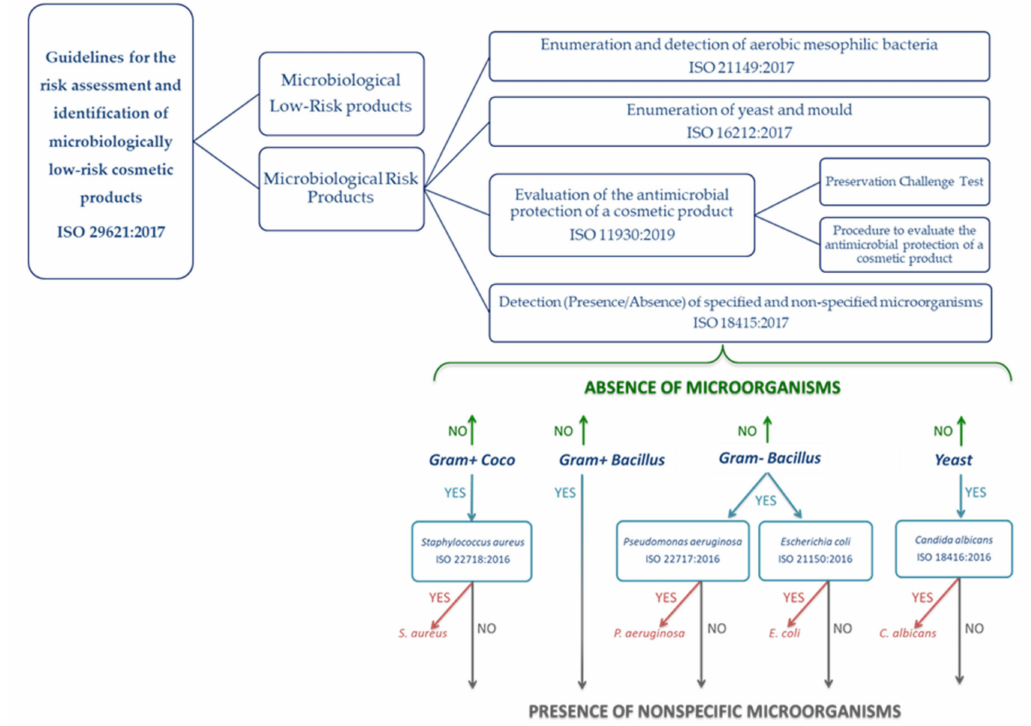
Figure 1. Recommended path in carrying out the microbiological control of cosmetics products with the correspondent ISO standards to be followed and the conclusions that may be